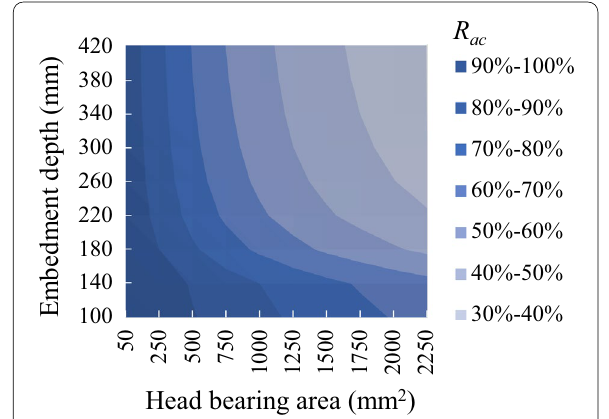
Fig. 24 Contribution of the anchorage concrete to the rotation of the column–base